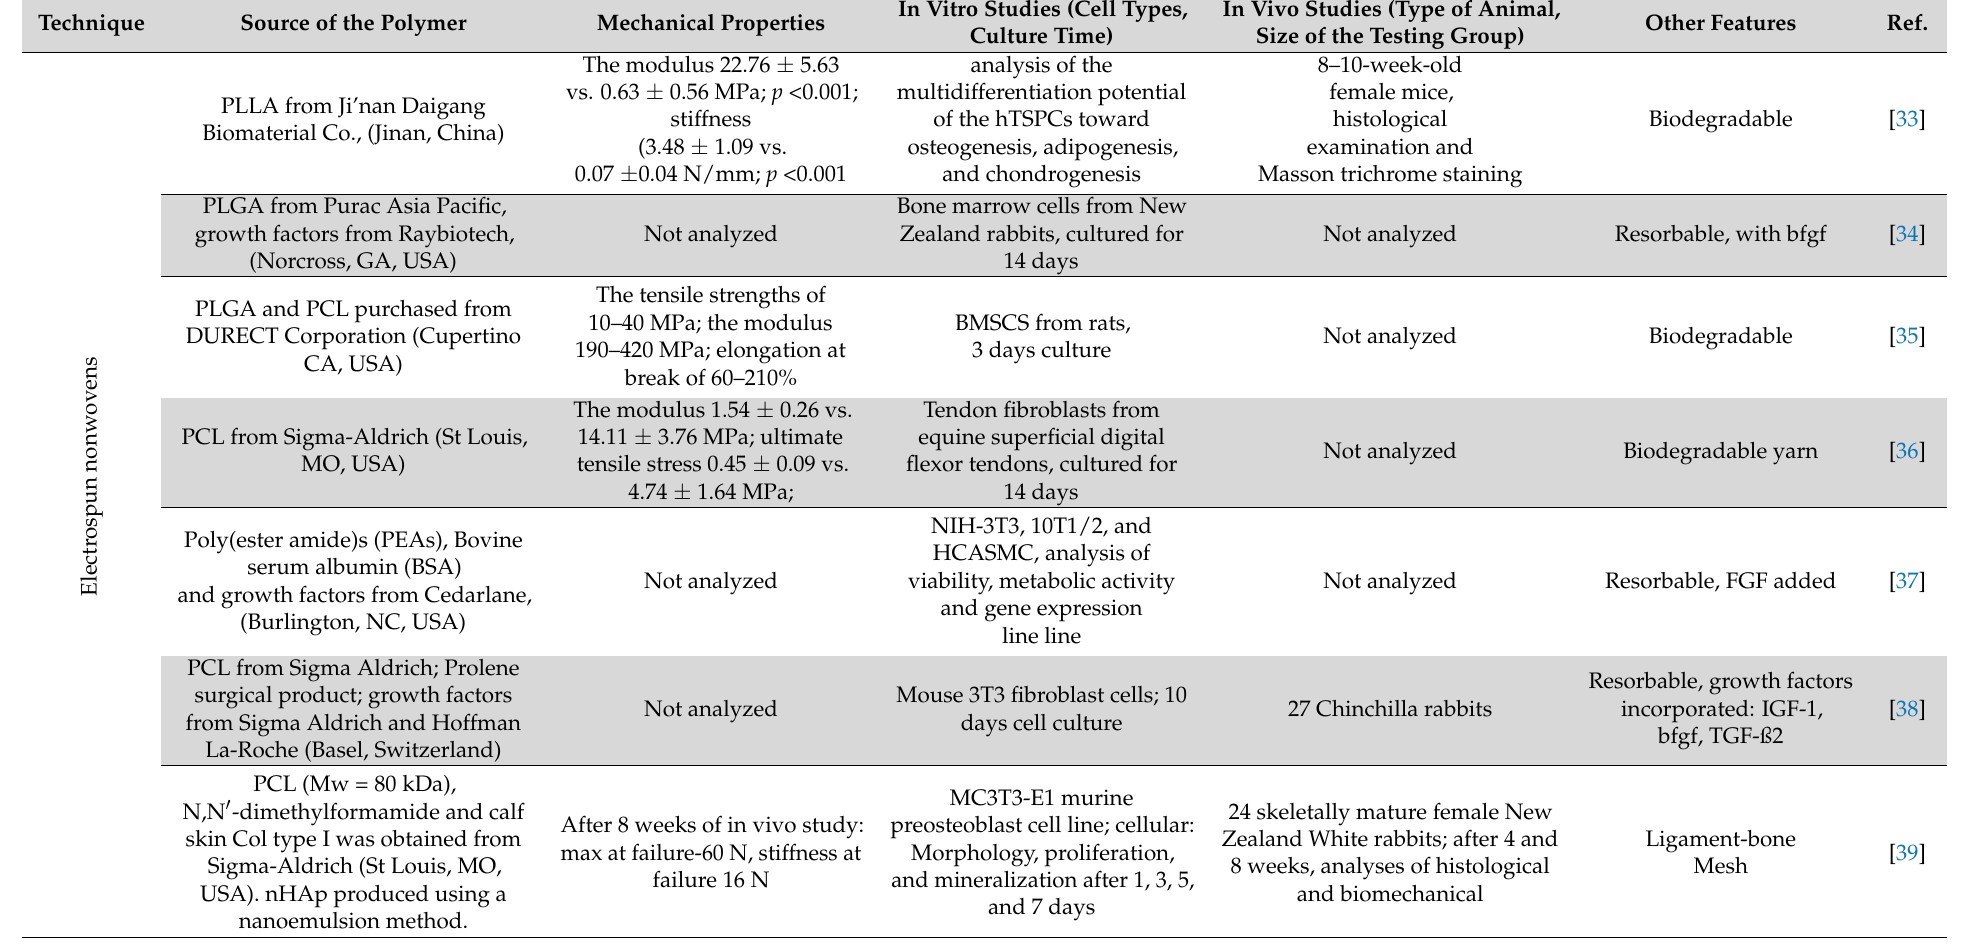
Table 3. Summary information on the development of grafts for ACL